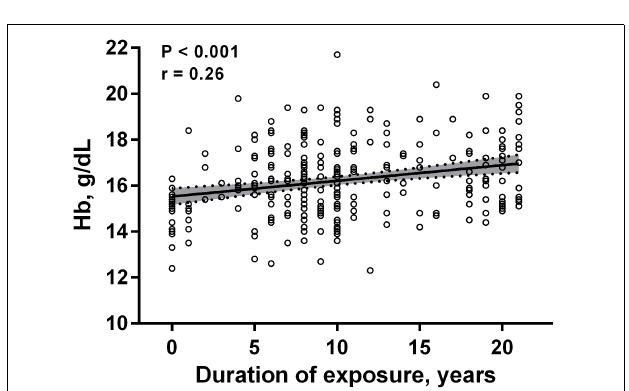
FIGURE 1 | Hemoglobin (Hb) levels in subjects according to their body mass index (BMI) category: normal weight ( < 25), overweight (25–30), and obese ( ≥ 30). ∗ P < 0.05 for differences between normal weight and obese subjects. Data presented as mean ± SEM. Statistical analysis was carried out using one-way ANOVA followed by Tukey’s multiple comparison test.